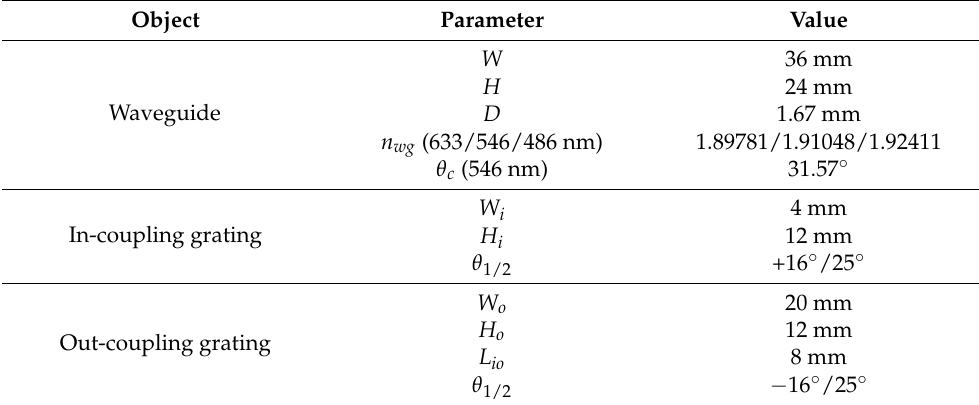
Figure 1. Cross-section of dual-channel waveguide, the top and bottom layers of which are referred to as channel 1 and channel 2, respectively. The left and right half-FOVs shall be of orthogonal polarizations, e.g., left-handed and right-handed circular polarizations. Gratings in channel 1—including both the in-coupling and out-coupling—are responsive merely to the light coming from the left half of FOV. Gratings in channel 2, on the other hand, will take care of the rest of FOV, i.e., the right half. Table 1. Parameters of waveguide and